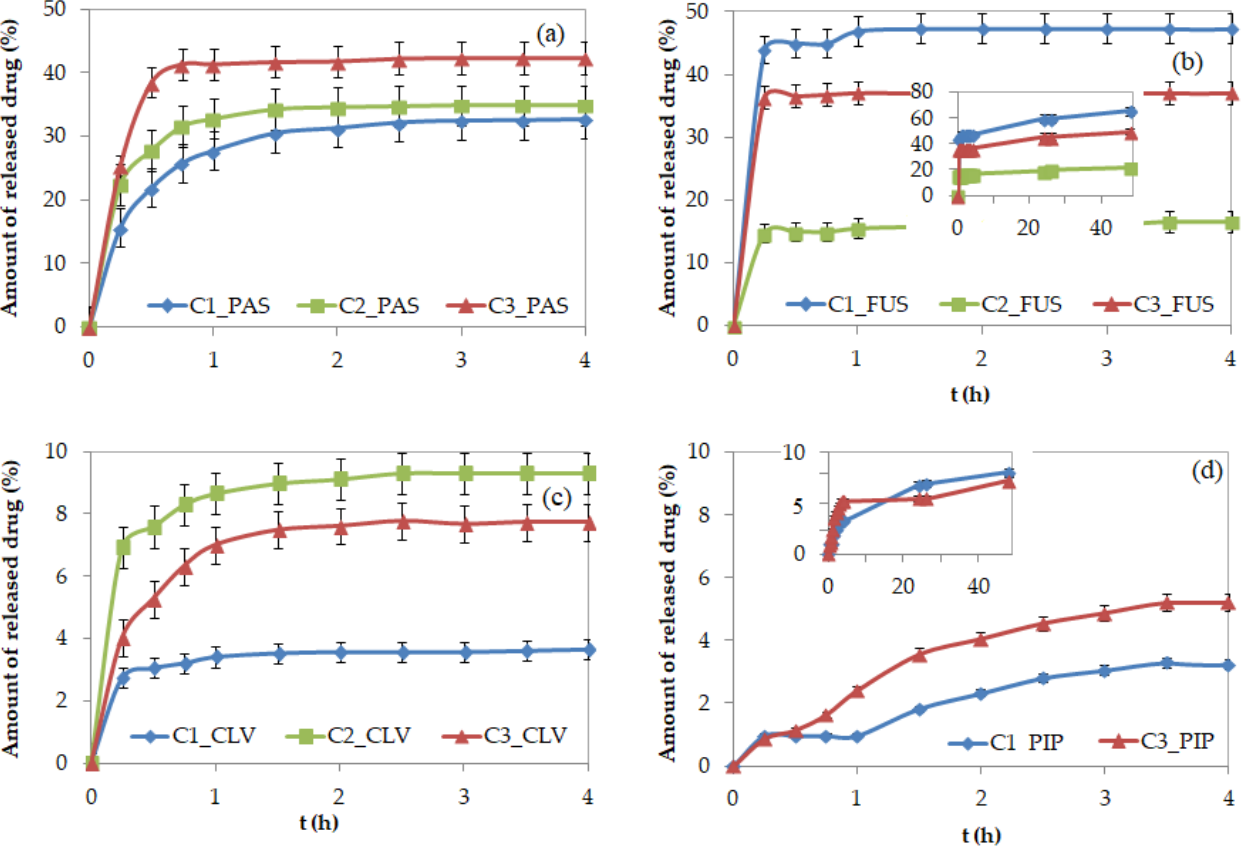
Figure 7. Kinetic release profiles of ( a ) PAS, ( b ) FUS, ( c ) CLV, and ( d ) PIP anions from conjugates based on PILs.